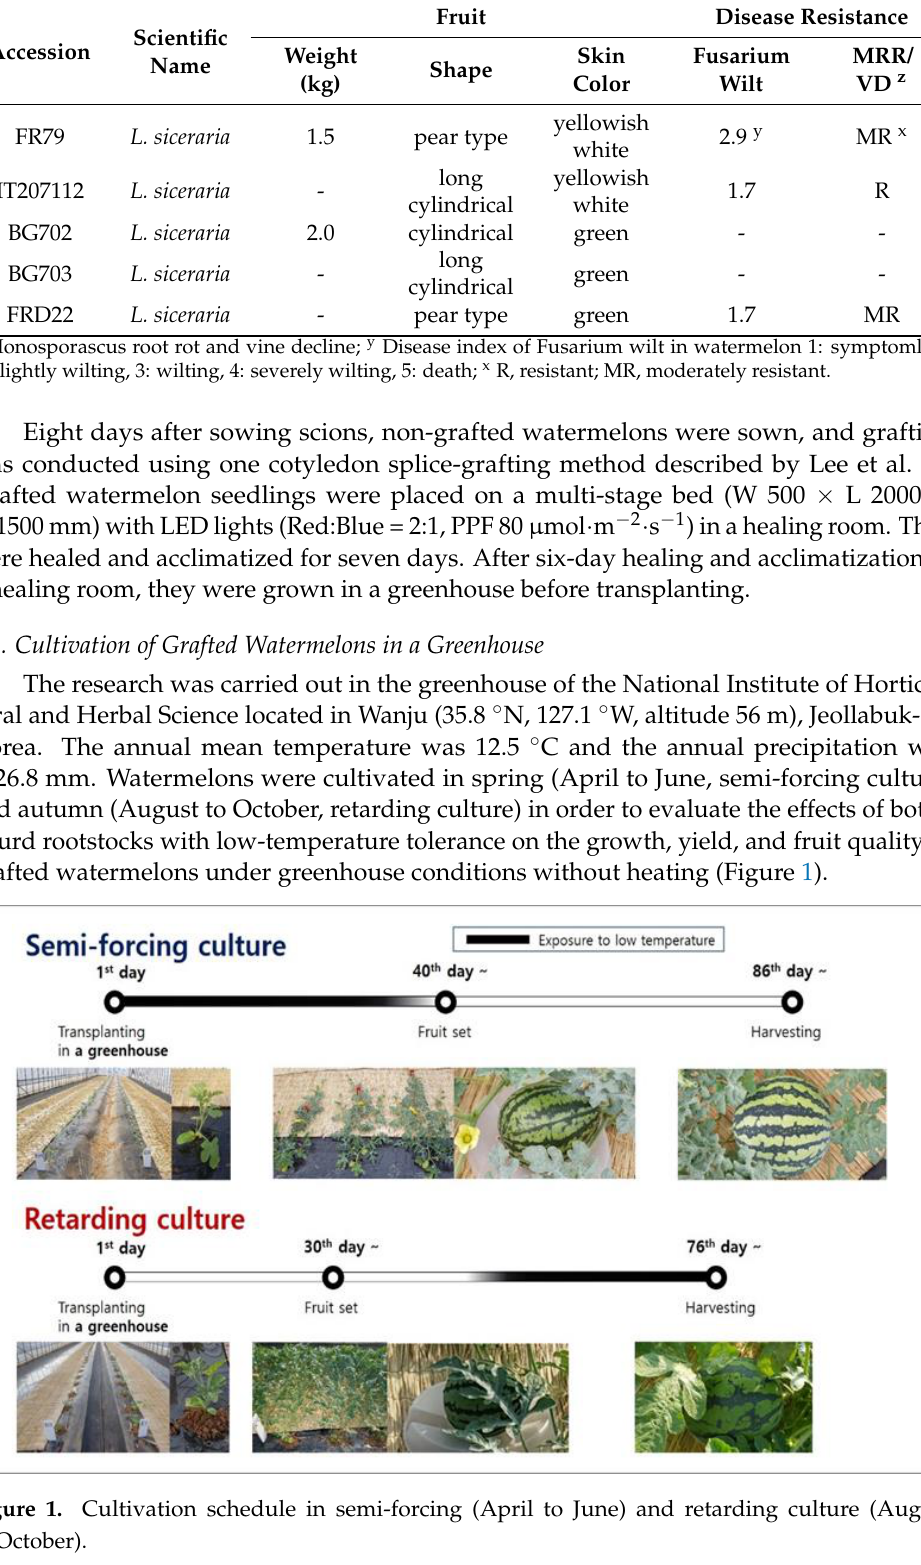
Table 1. The characteristics of bottle gourd accessions used as rootstocks.